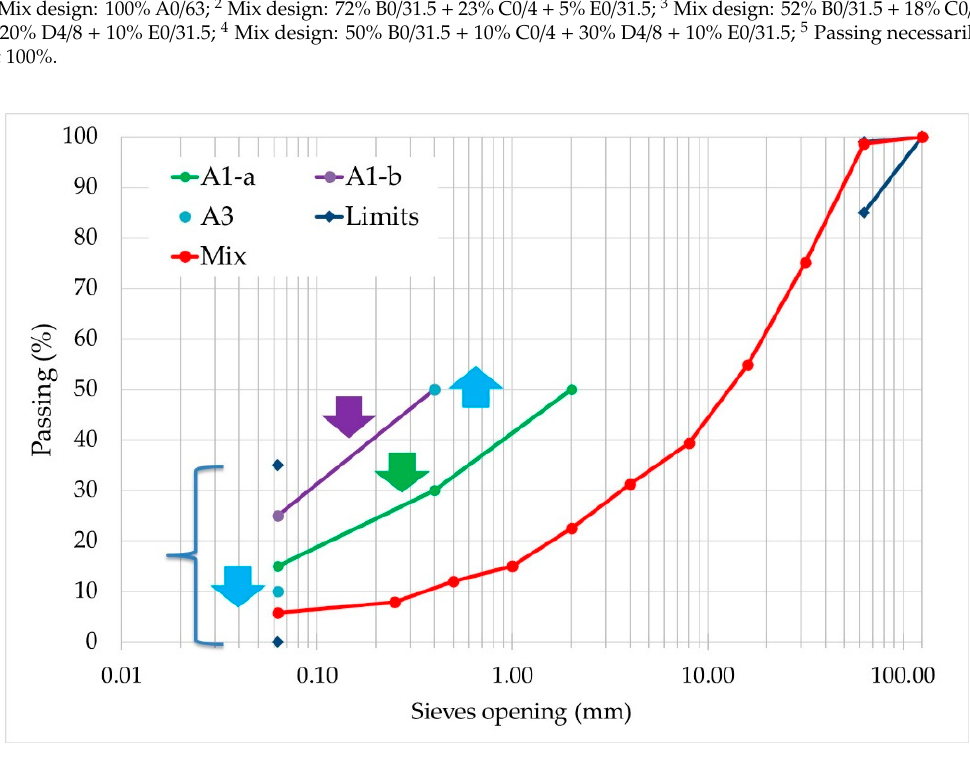
Figure 2. Particle size distribution and grading envelope 0/63 GN for embankment constructed of construction and demolition waste (CDW).